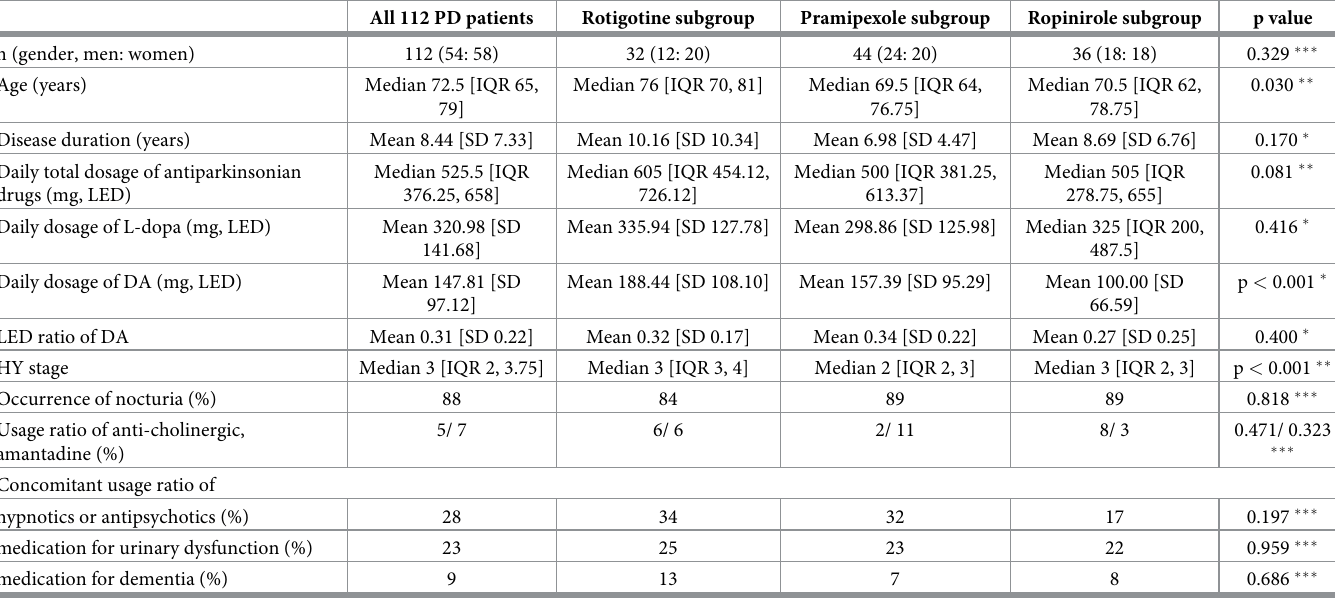
Table 1. Characteristics of the 112 PD patients according to DA